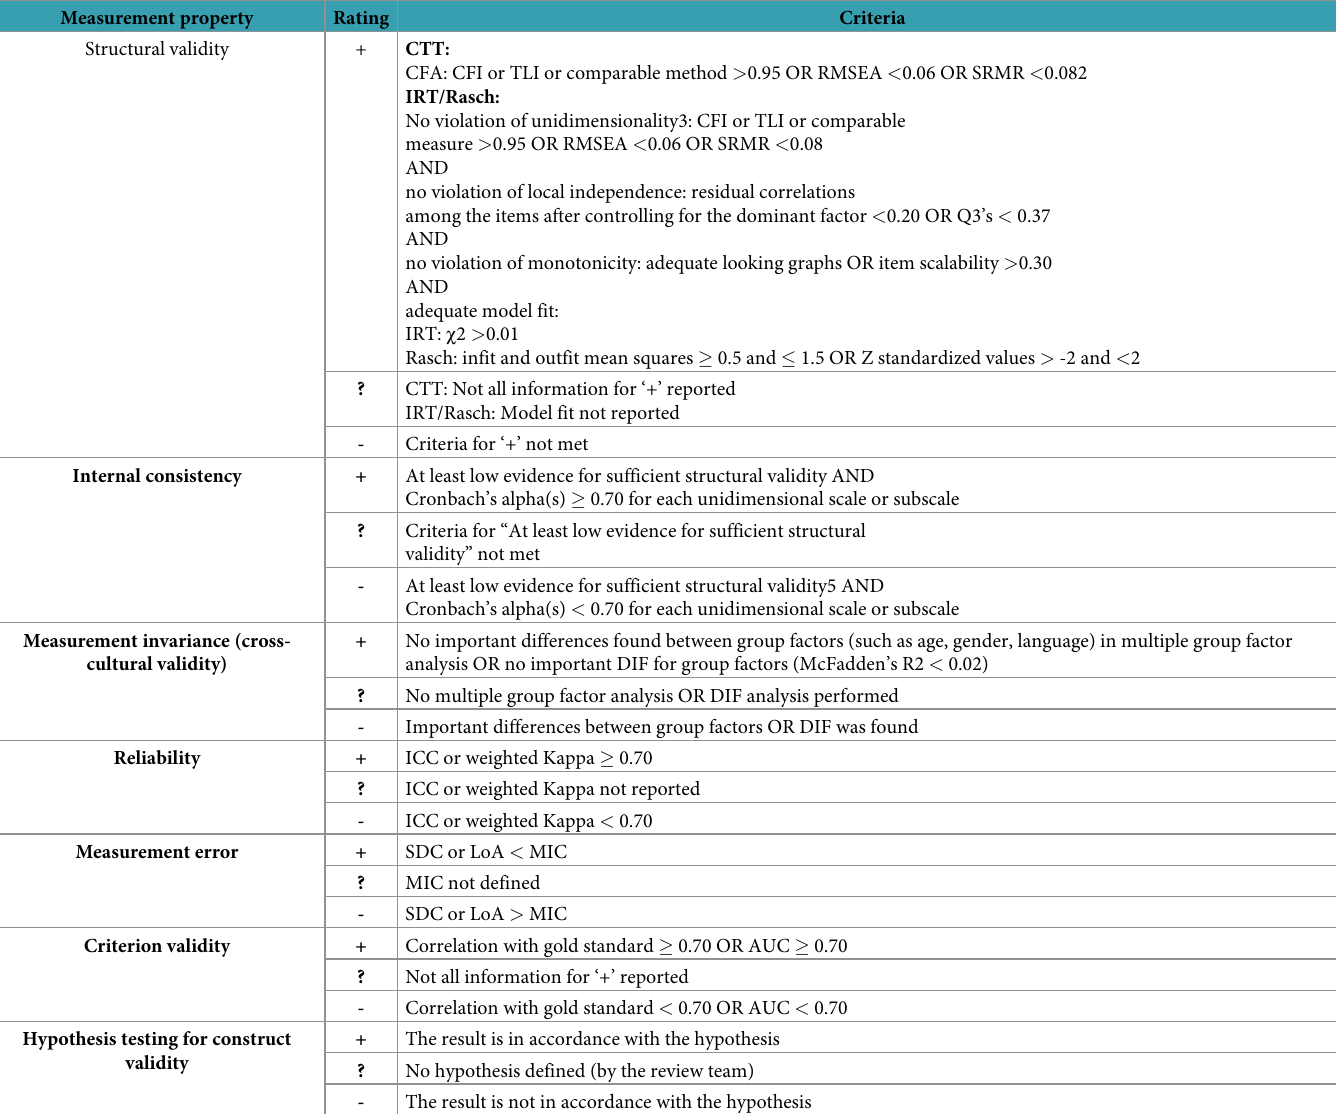
Table 1. Criteria for overall assessment of psychometric properties according to COSMIN (Mokkink et al. 2018, COSMIN User Manuel). Measurement property Rating Criteria Structural